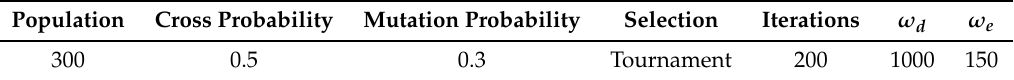
Table 4. The parameters of TLTD.